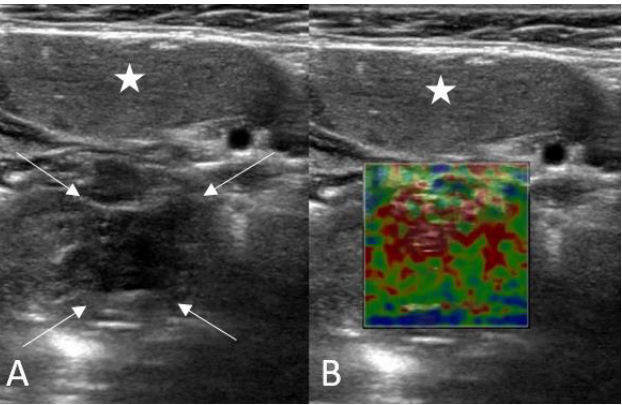
Figure 2. Shear wave elastography (SWE) evaluation of the palatine tonsil ( A , B ): Asterisk: Subman- dibular gland, Arrows: Palatine tonsil).